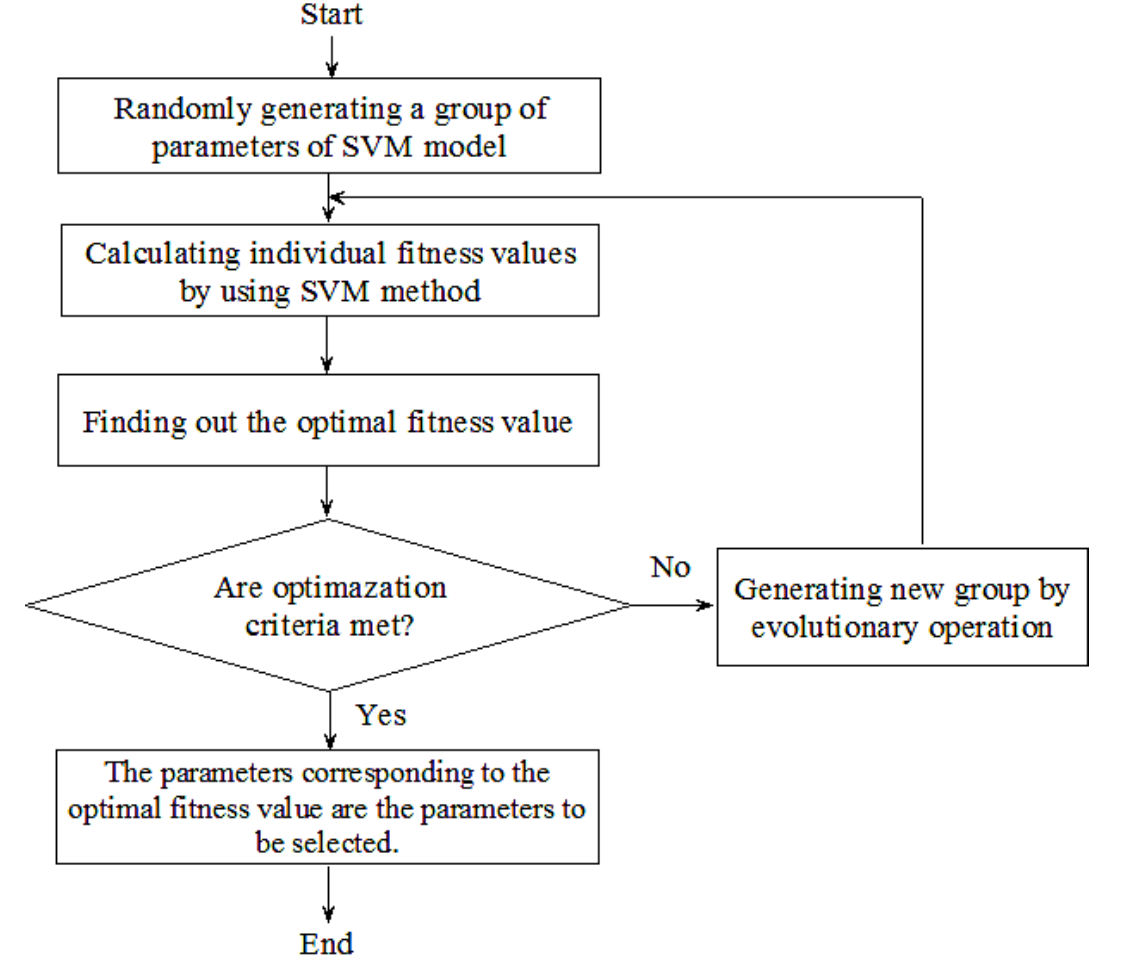
Fig. 1. Basic flowchart of GA–SVM